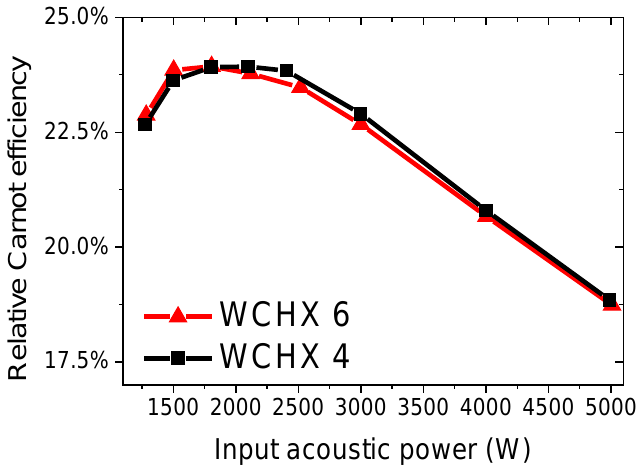
Figure 7. Dependence of relative Carnot efficiency on the input acoustic power for WCHXs 4 and 6.